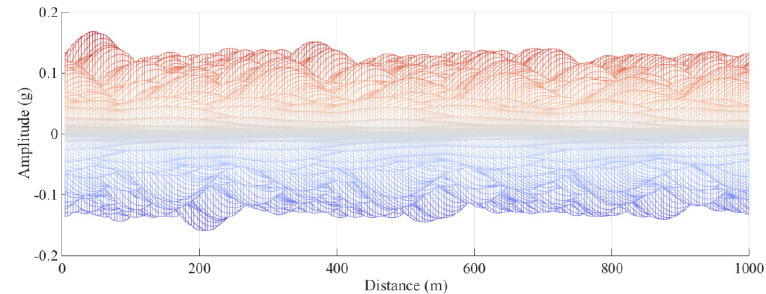
Figure 27. Evolution of the amplitude of ground motion field with distance.